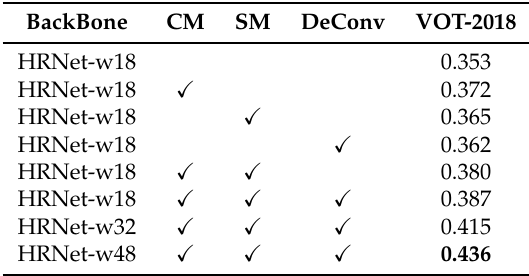
Table 3. Ablation study of the proposed different modules on VOT2018 with EAO score. CM: Channel Mask, SM: Spatial Mask, DeCon: Deformable